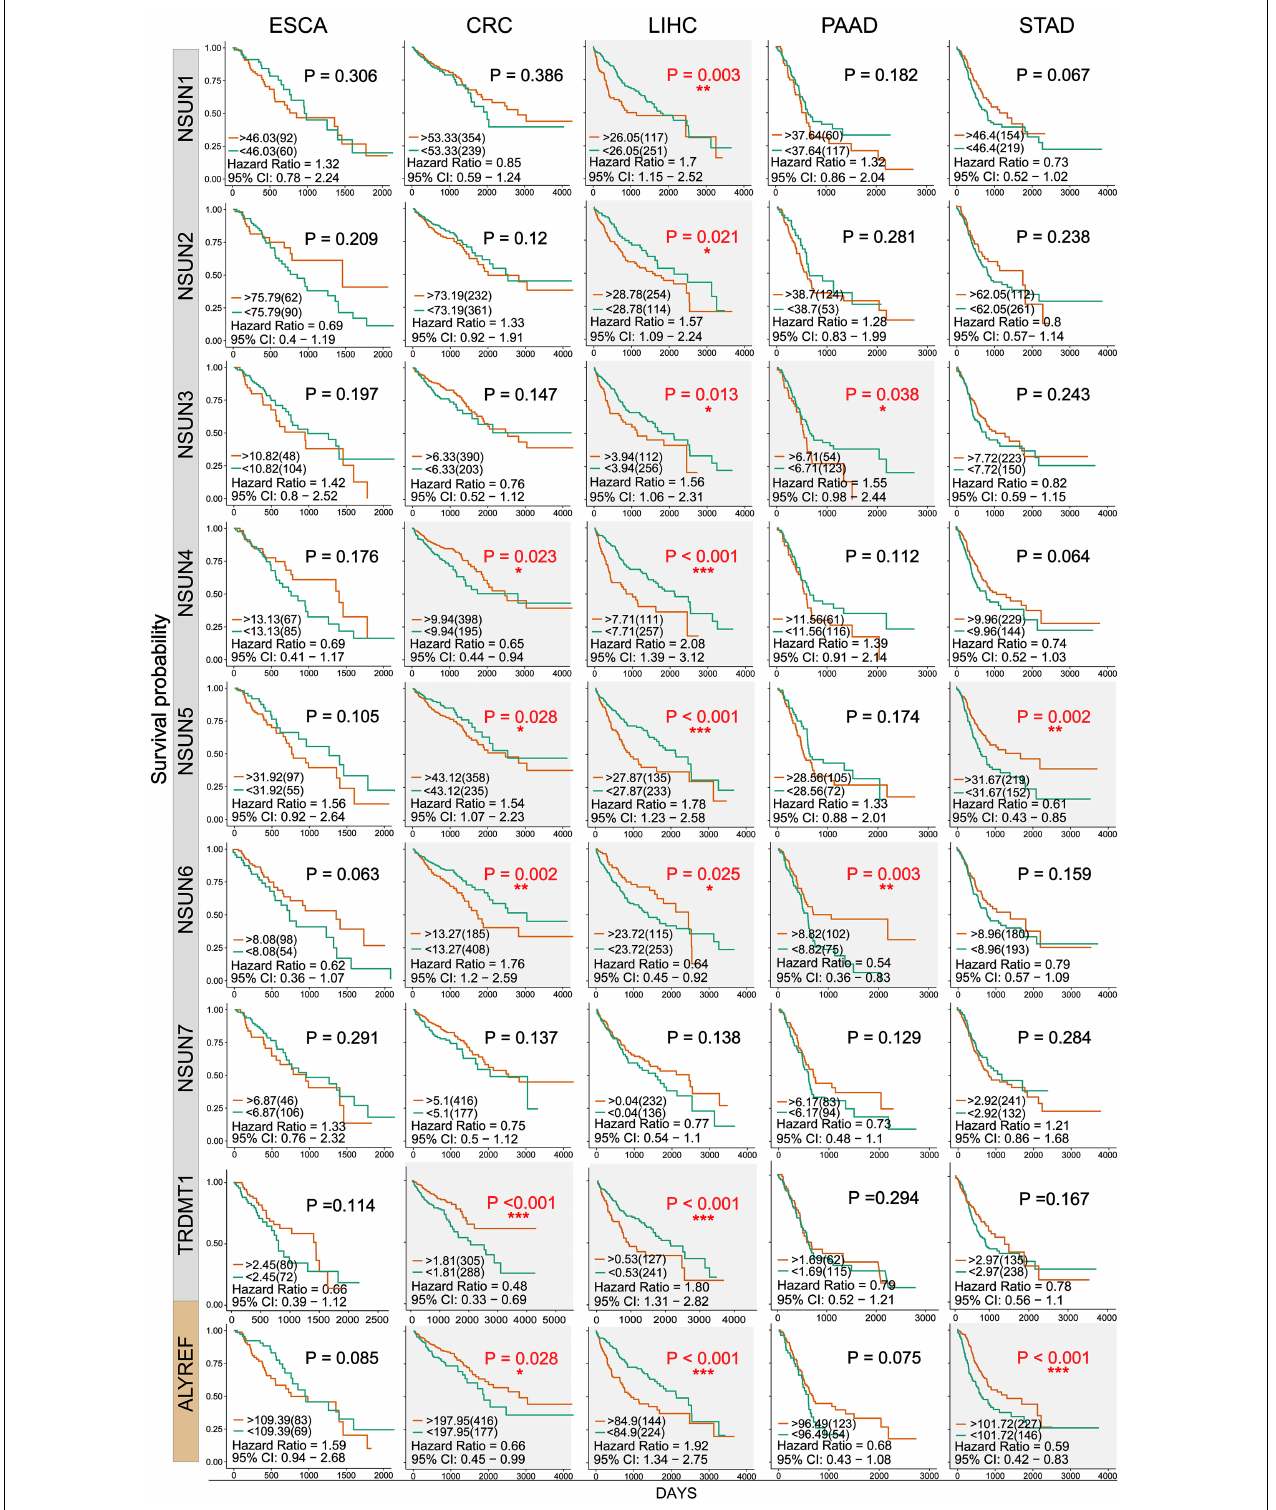
FIGURE 4 | Kaplan–Meier survival curves of m 5 C regulatory factors in GI cancer. Kaplan–Meier survival curves were drawn based on the differential expression level of m 5 C regulatory factors in GI cancer. The red and green curves showed survival curves of the high and low expression groups, respectively. ∗ P < 0.05, ∗∗ P < 0.01, and ∗∗∗ P < 0.001 between the two